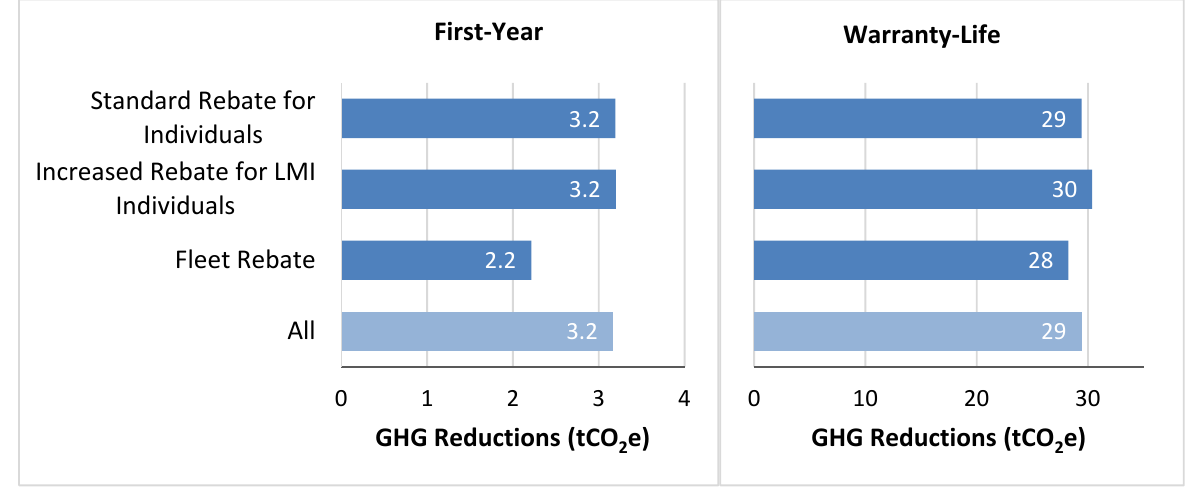
Figure 2. Per-Vehicle GHG Reduction Estimates by Rebate Type and Quantification Period.